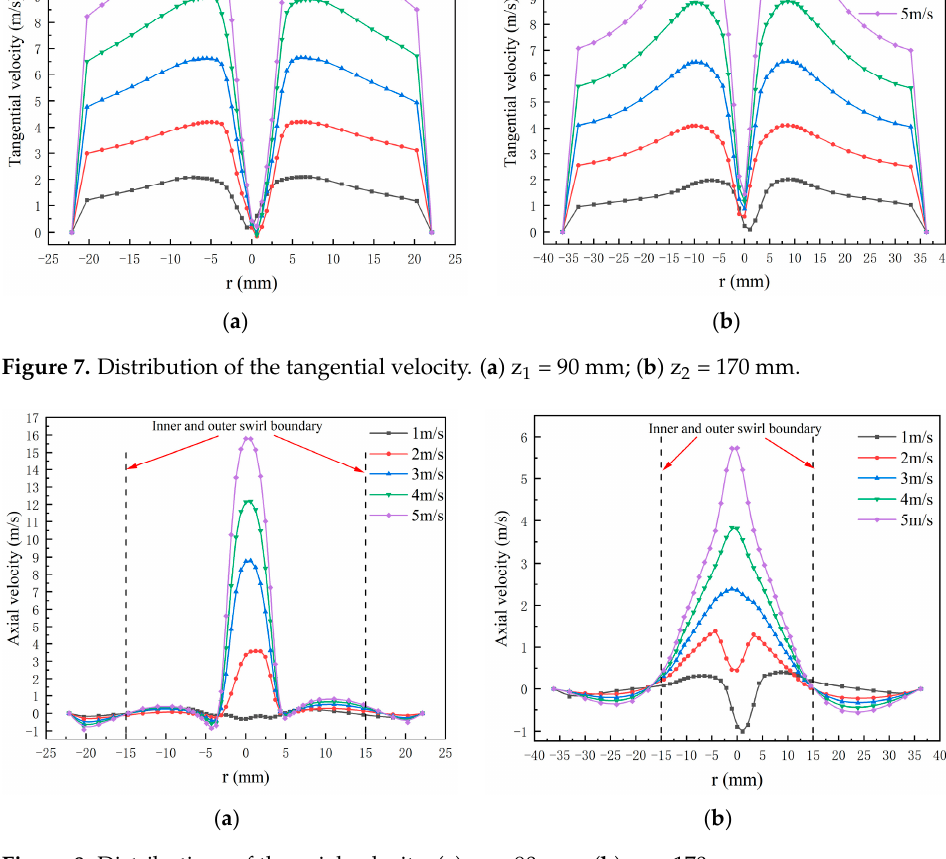
Figure 7. Distribution of the tangential velocity. ( a ) z 1 = 90 mm; ( b ) z 2 = 170 mm.